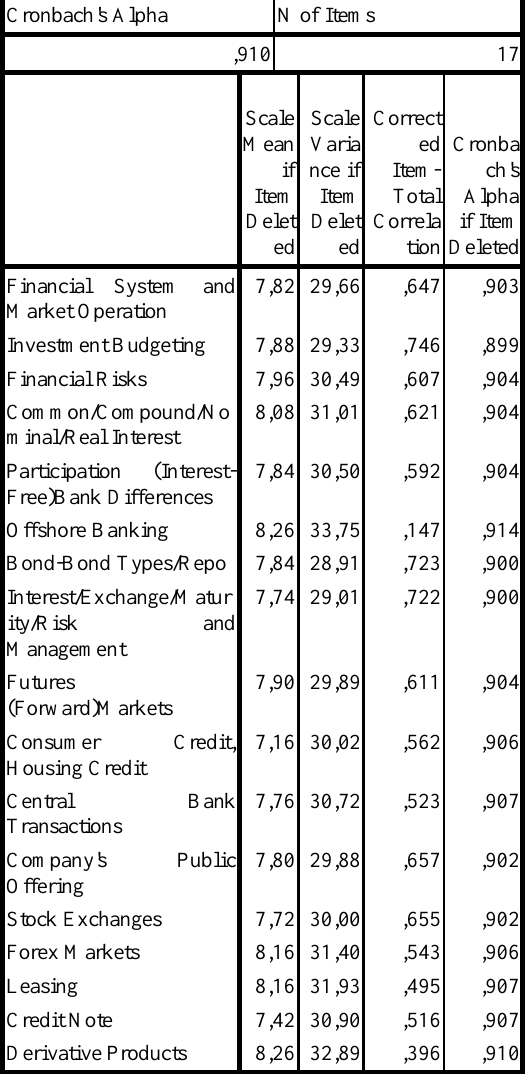
Table 4 . Reliability